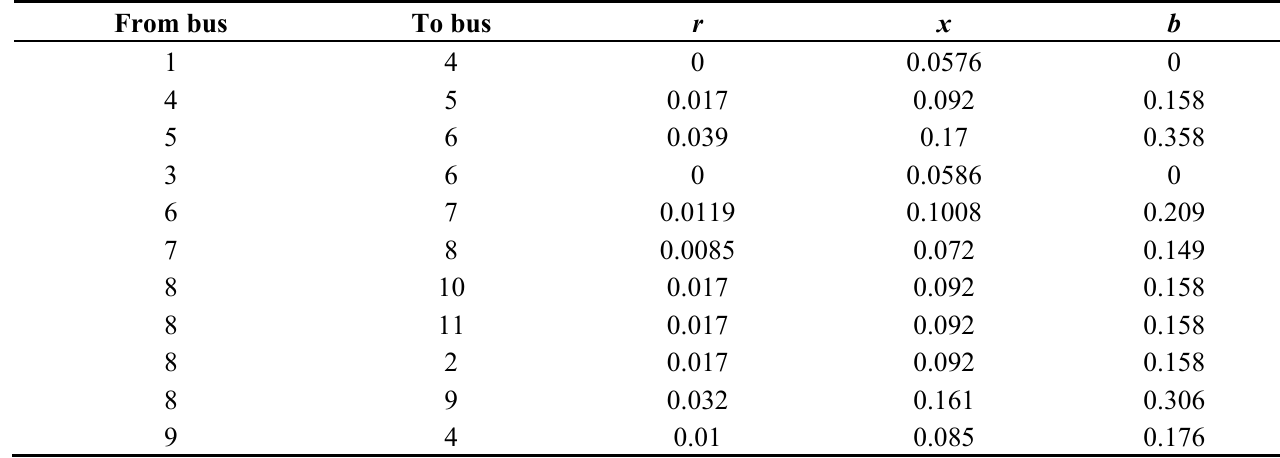
Table A3. Branch parameters.